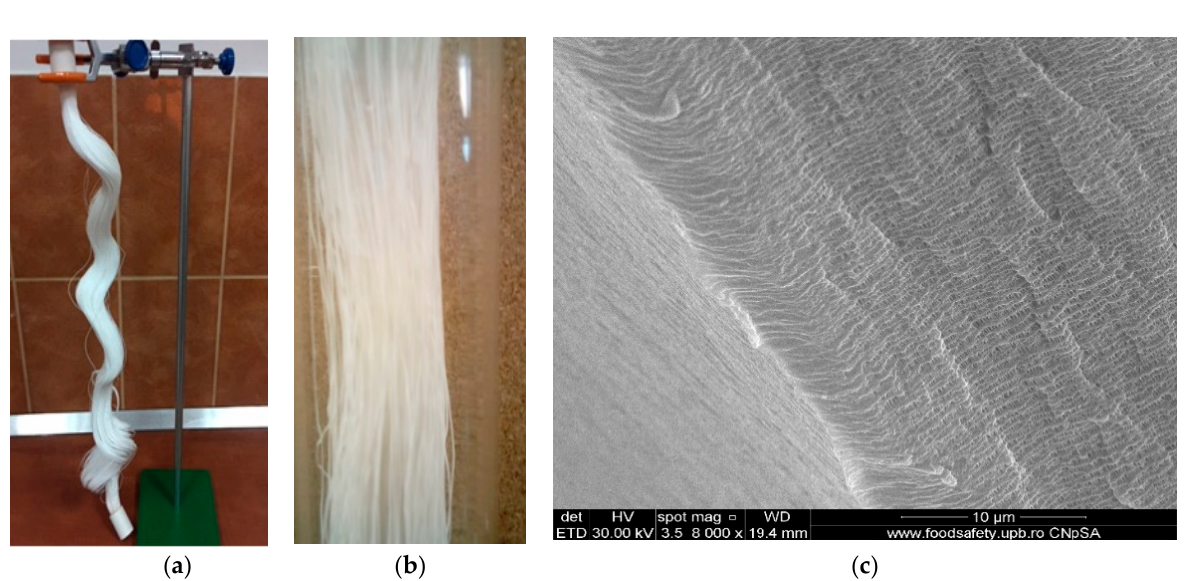
Figure 1. Polypropylene hollow fiber: ( a ) hollow fiber bundle; ( b ) detail; ( c ) individual hollow fiber cross-section (SEM image).